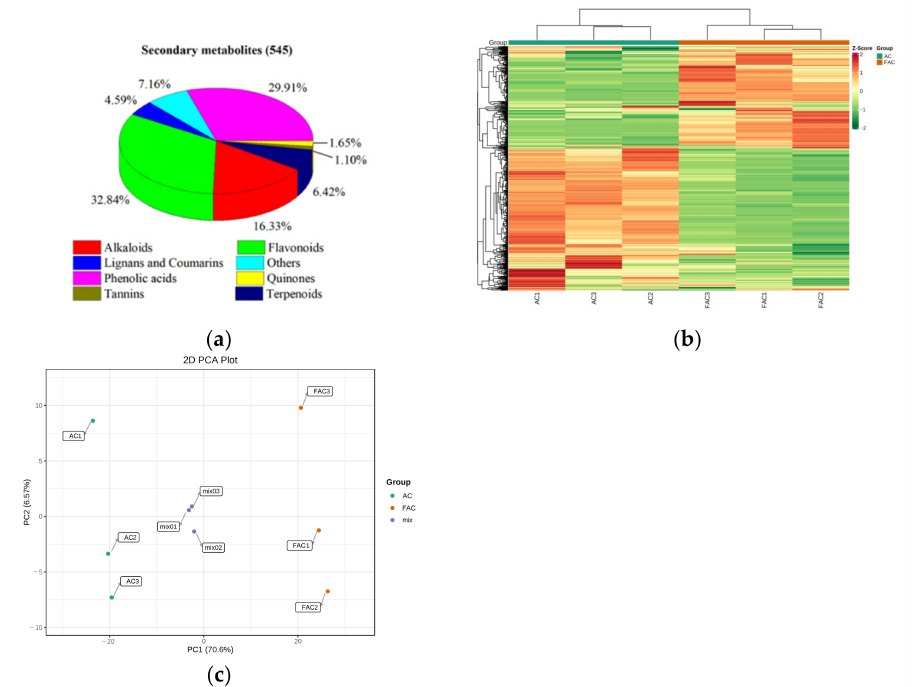
Figure 3. Secondary metabolites identified. ( a ) Classification of the 545 secondary metabolites of AC